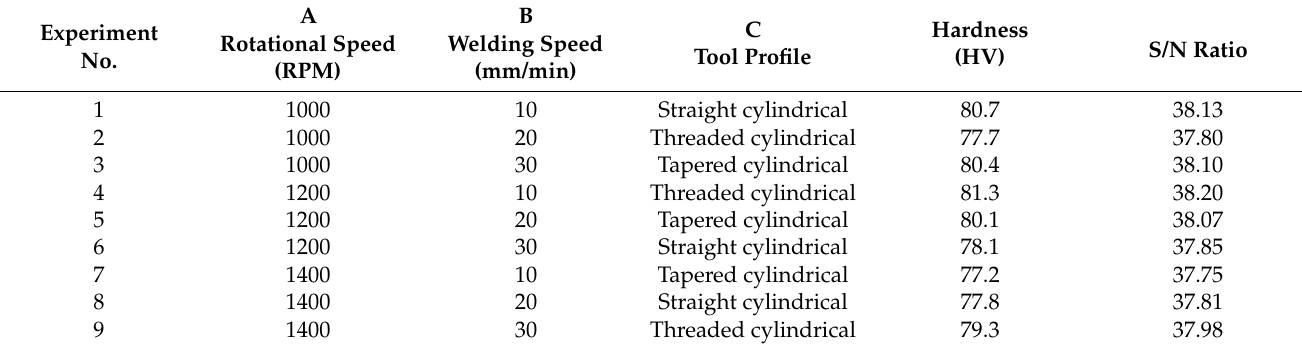
Table 5. Experimental layout: L9 orthogonal array, means values hardness, and S/N ratio values.